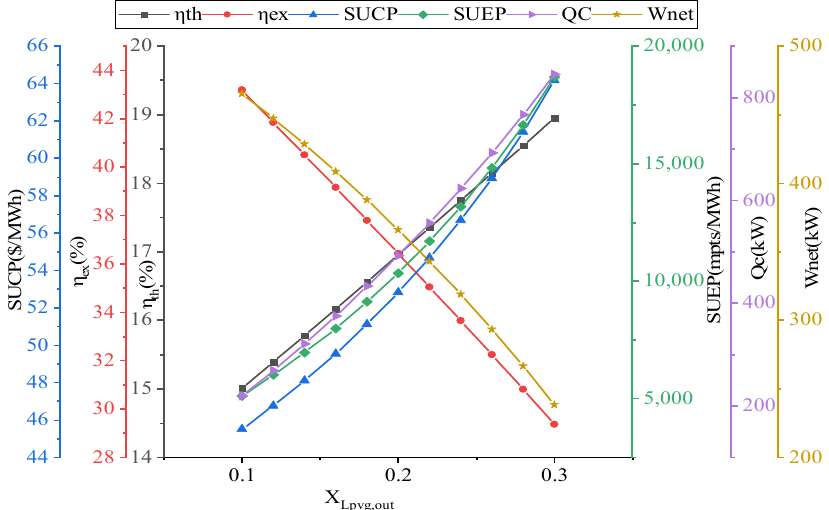
Figure 5. Effect of dryness of the outlet working fluid of the low-pressure evaporator generator on system performance.